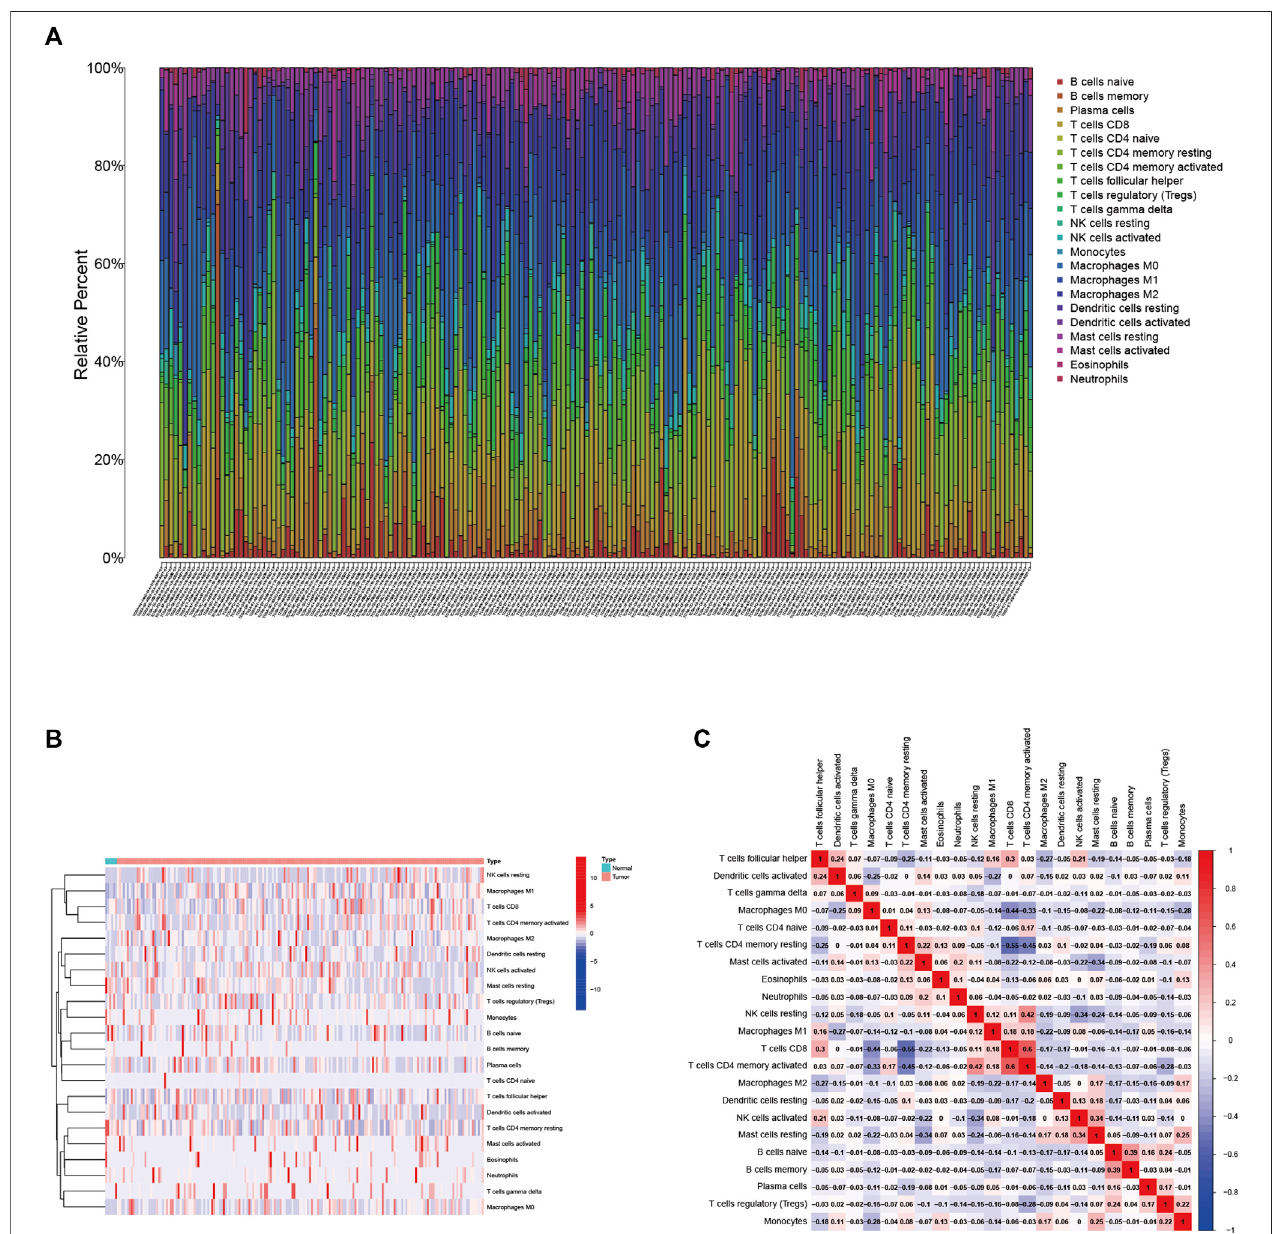
FIGURE 1 | (A) Immune cell in fi ltration in the BLCA tumor immune environment. Subpopulations of 22 immune cell subtypes (B) and scale heatmap of 22 TICs in each BLCA sample (C) . Intrinsic correlation of 22 in fi ltrating immune cells in